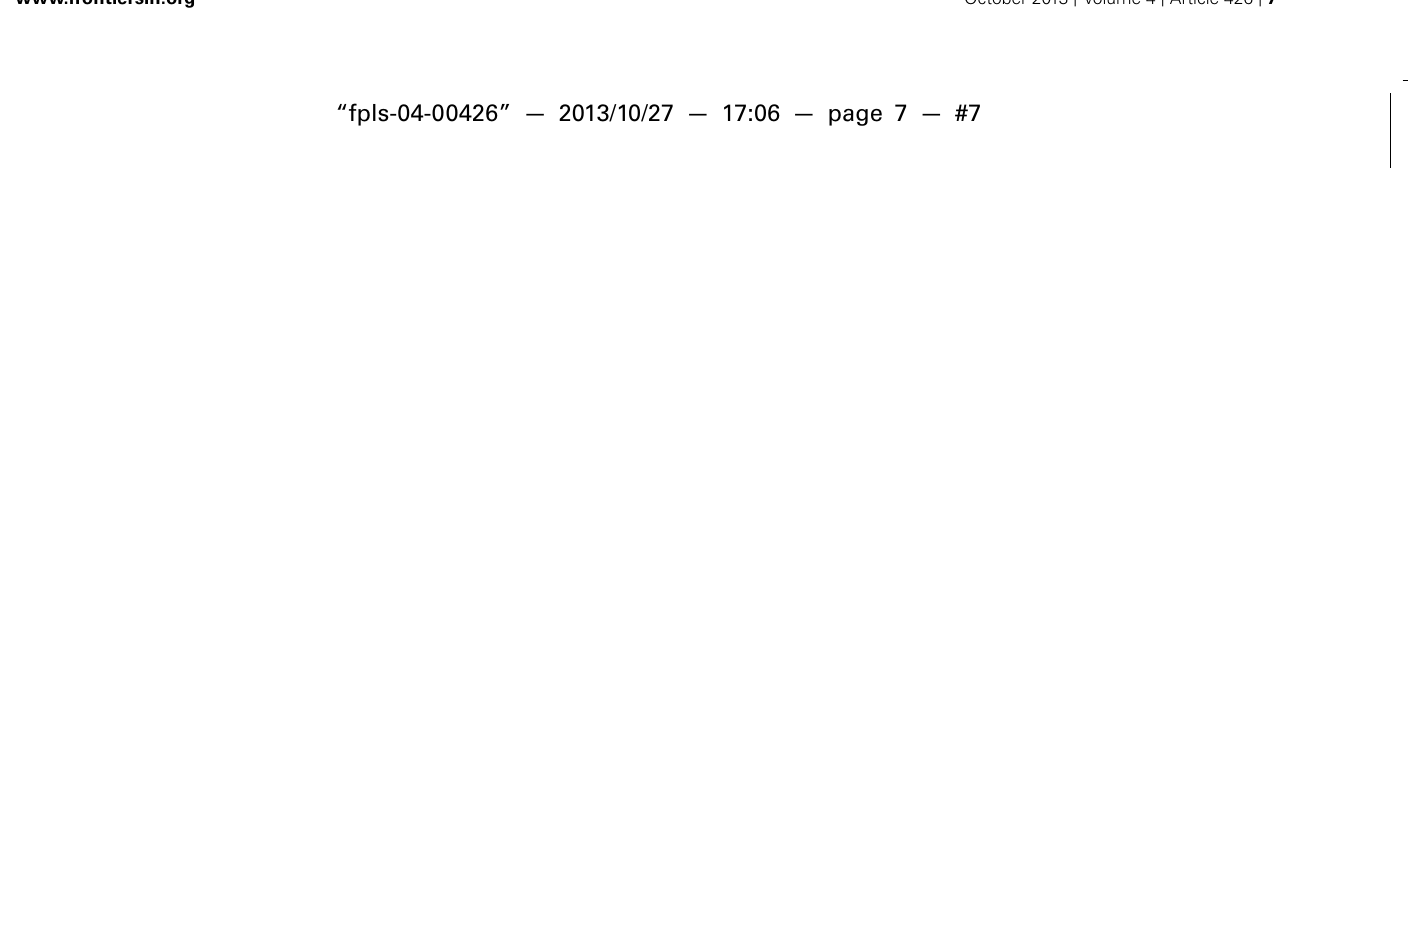
P ( P < 0.05) for each gene, according to the Student’s t -test or to the unequal variance t -test where appropriate. (A) Genes involved in Pi acquisition (root Pi transporters: MtPT1 , MtPT2 , MtPT3 , MtPT5 ) and markers of Pi starvation ( MtPHO2 , MtPHR1 , Mt4 , MtSpx ). (B) Strigolactone biosynthetic